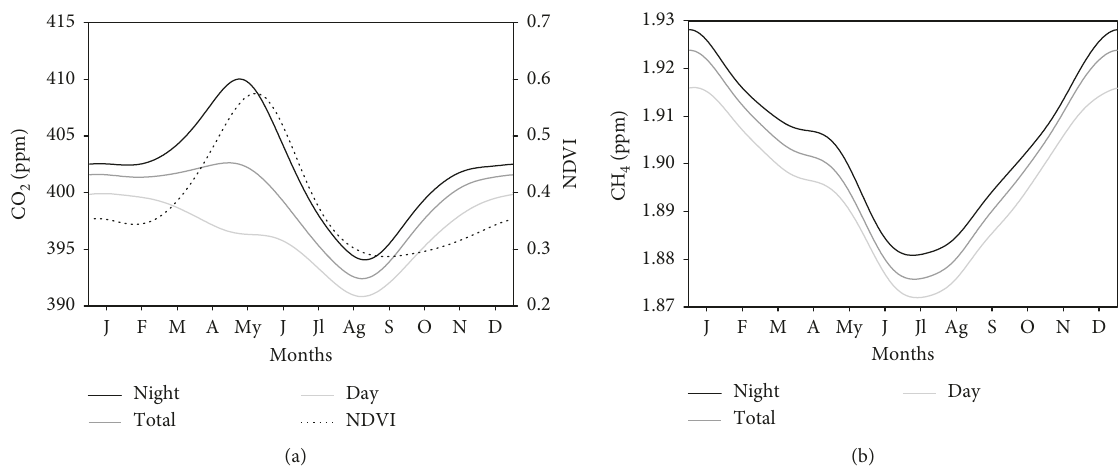
Figure 2: Annual evolution of NDVI and CO 2 (a) and CH 4 (b). Trace gas concentrations have been considered for all the data and for day and night periods. Table 1: Availabilities and average concentrations calculated with values provided by equation (1).